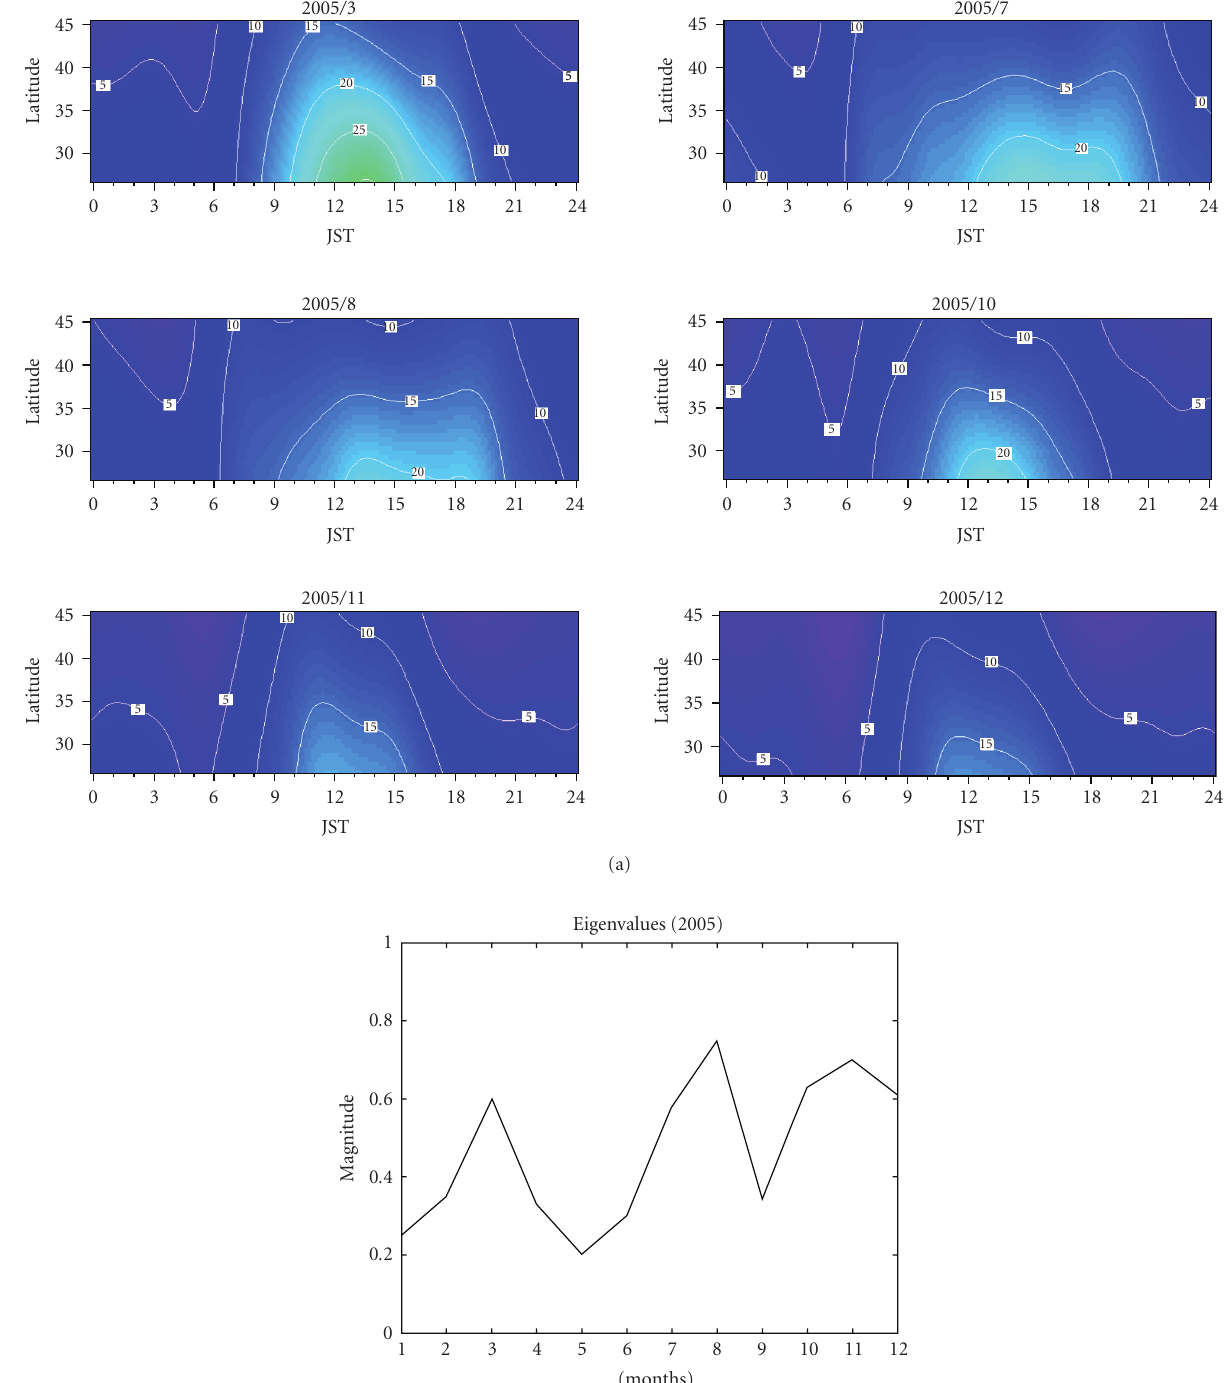
Figure 5: (a) shows the latitude-time TEC records in Japan for 2005 (Unit: TECu). (b) shows 12 principal eigenvalues in 2005. Six larger principal eigenvalues are represented in March, July, August, October, November, and December in which six earthquakes occurred on March 20, July 23, August 16, October 19, November 14, and December 2 (Table